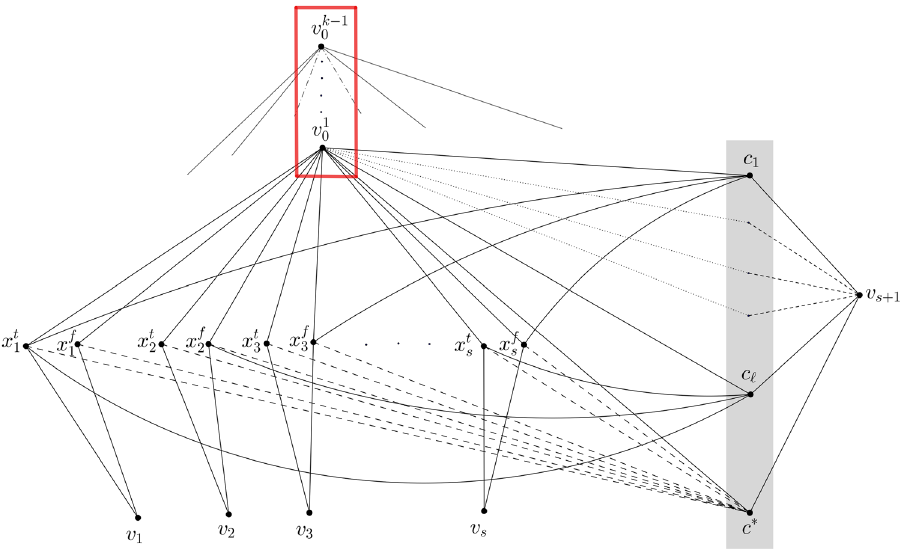
Figure 2: An illustration of the construction for 3 - SAT reduction: The clauses C 1 and ℓ C corresponding to the vertices c 1 and ℓ c , resp.,